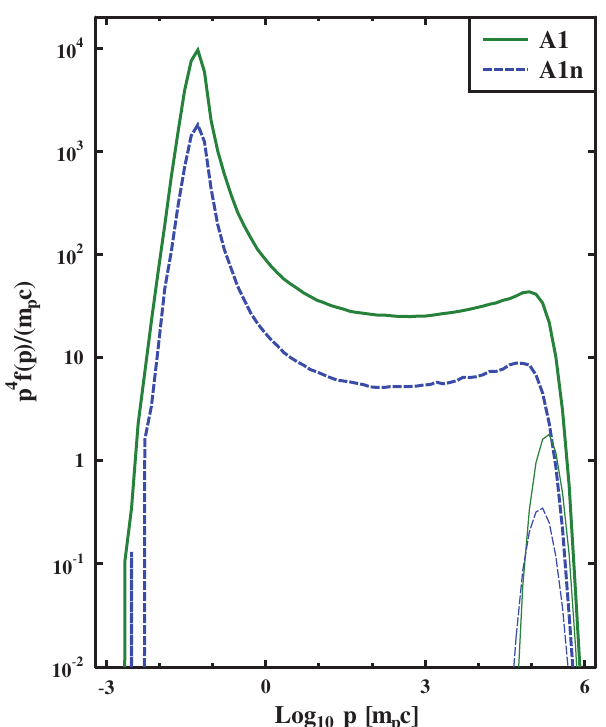
Figure 11. Particle distribution function in the shock rest frame, the thick curves correspond to the point x = 0 (the front shock), the thin curves correspond to the point x = x FEB . The correspondence to Table 1 is reflected in the legend.